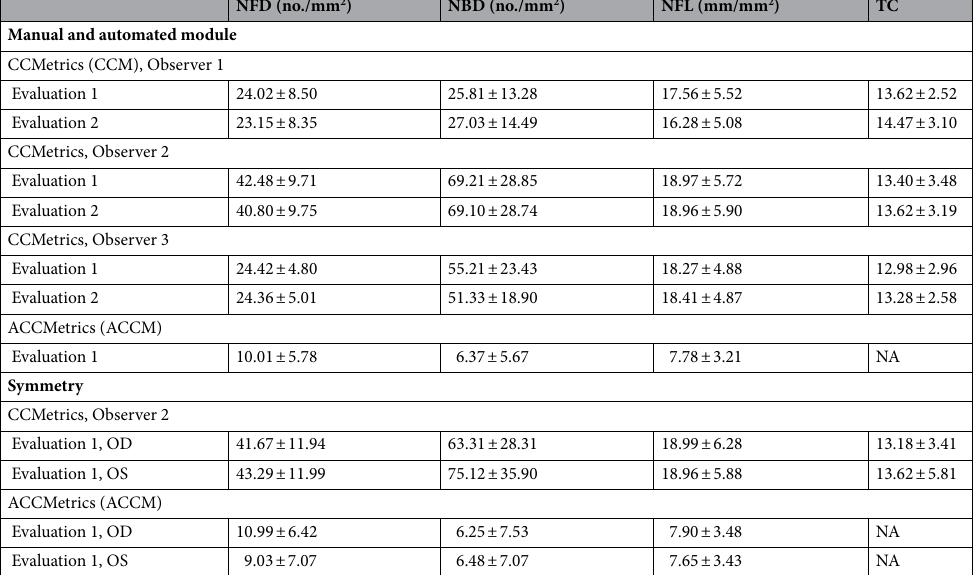
Table 1. The CCMetrics (CCM) values of NFD, NBD and NFL in the first and the second evaluations from the original group and the ACCMetrics (ACCM) values and the values of both eyes from the first visit of the observer 2 and ACCM. Results are expressed as Mean ± SD. NFD (nerve fiber density) is measured in number of fibers/mm 2 , NBD (nerve branch density) is measured in number of branch points on the main fibers/ mm 2 , NFL (nerve fiber length) is measured in total length of fiber (mm/mm 2 ), TC (tortuosity coefficient) is measured in main fiber average tortuosity, OD (Oculus Dexter) represents right eye, OS (Oculus Sinister) represents left eye, NA